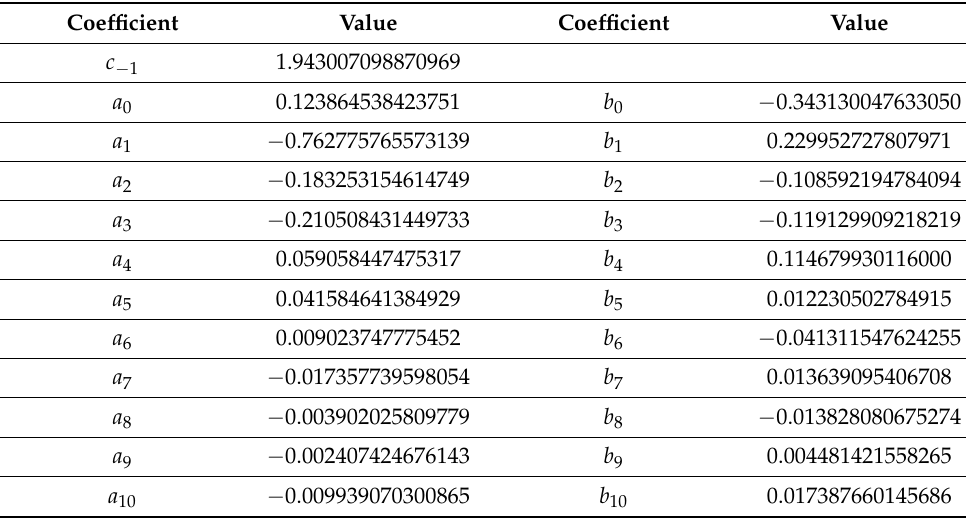
Table 1. The values of c − 1 , a k , b k ( k = 0, 1, 2, 3, . . . , 10). Coefficient Value